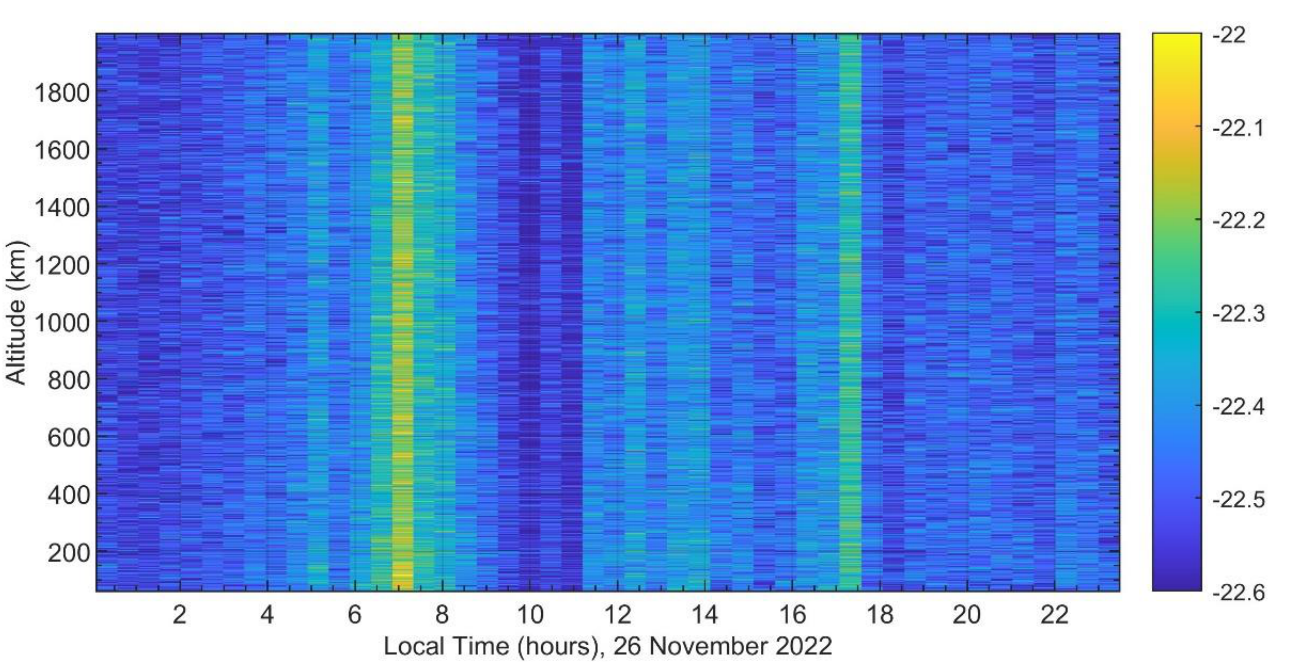
Figure 9. Local time and altitude variation of the measured noise in dBw in a non-transmitting experiment made by SYISR on 26 November 2022. The signal was integrated within 1 min.